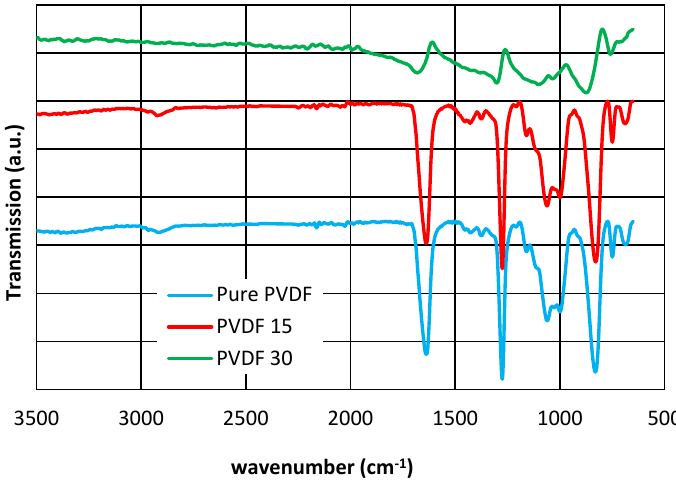
Figure 5. ATR-FTIR spectra of: ( a ) Pure PVDF; ( b ) PVDF15; and ( c ) PVDF30.